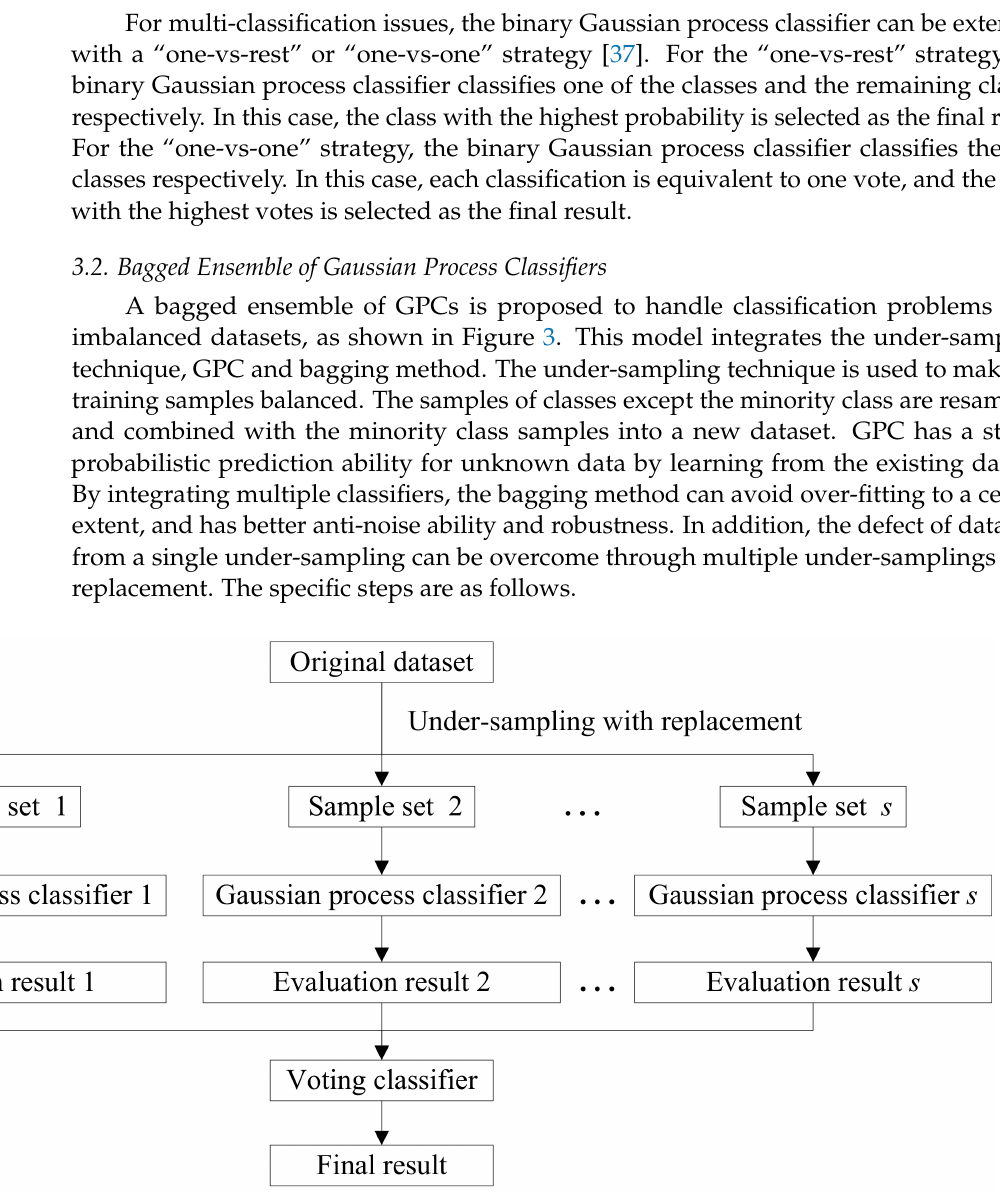
Figure 3. Diagram of a bagged ensemble of Gaussian process